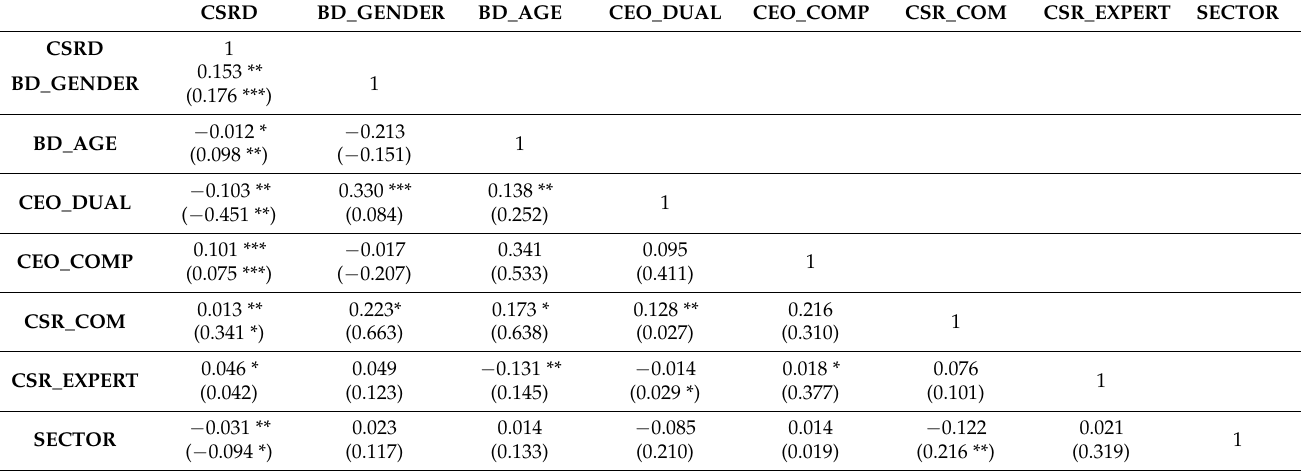
Table 4. Pearson correlation analysis.